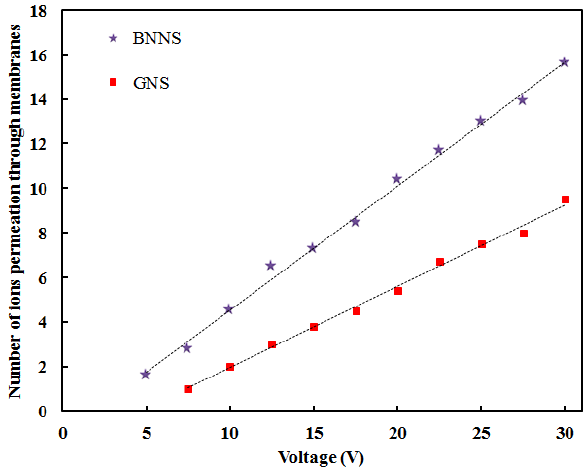
Figure 4. The number of Ni 2+ passing through the pore of GNS and BNNS.